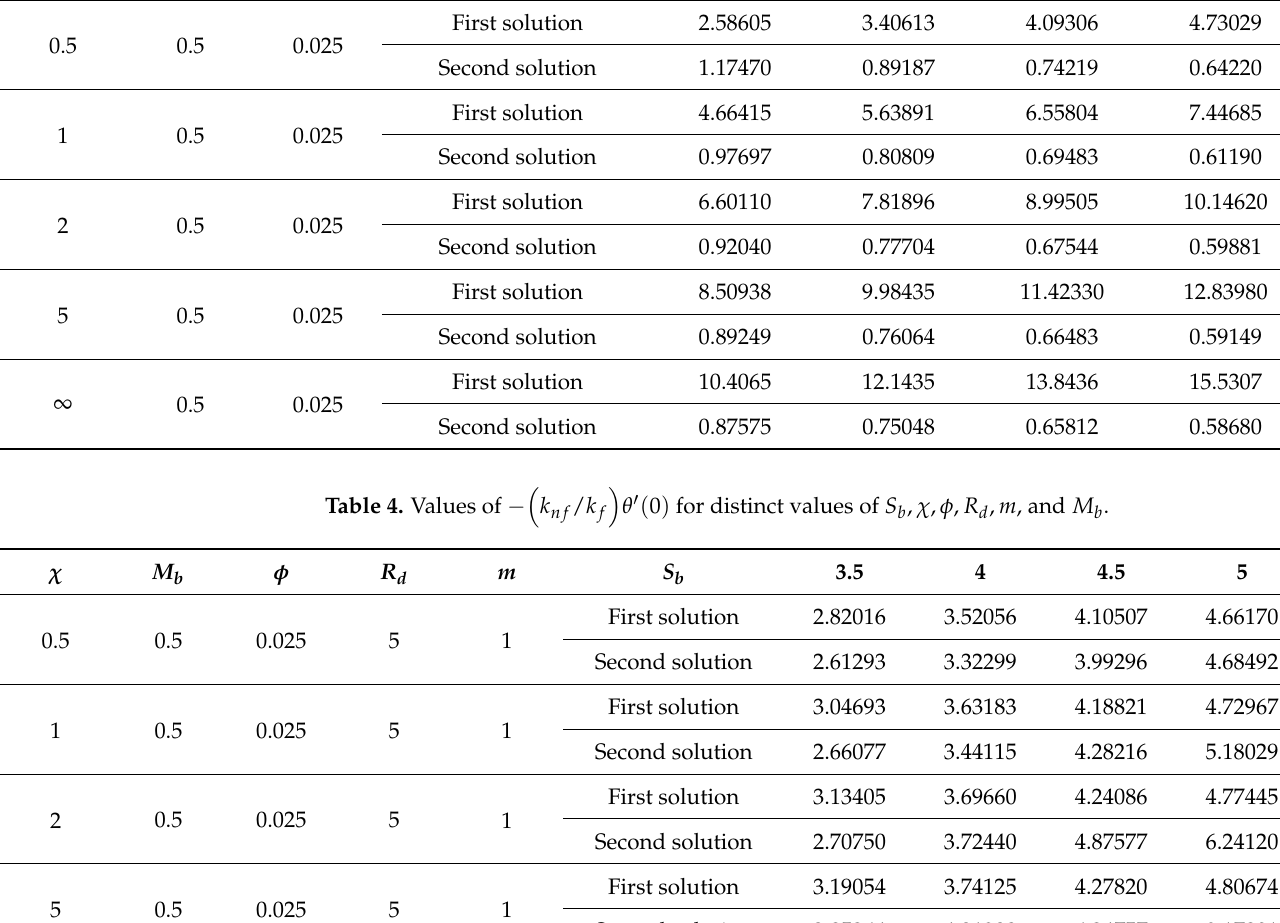
Table 3. Values of